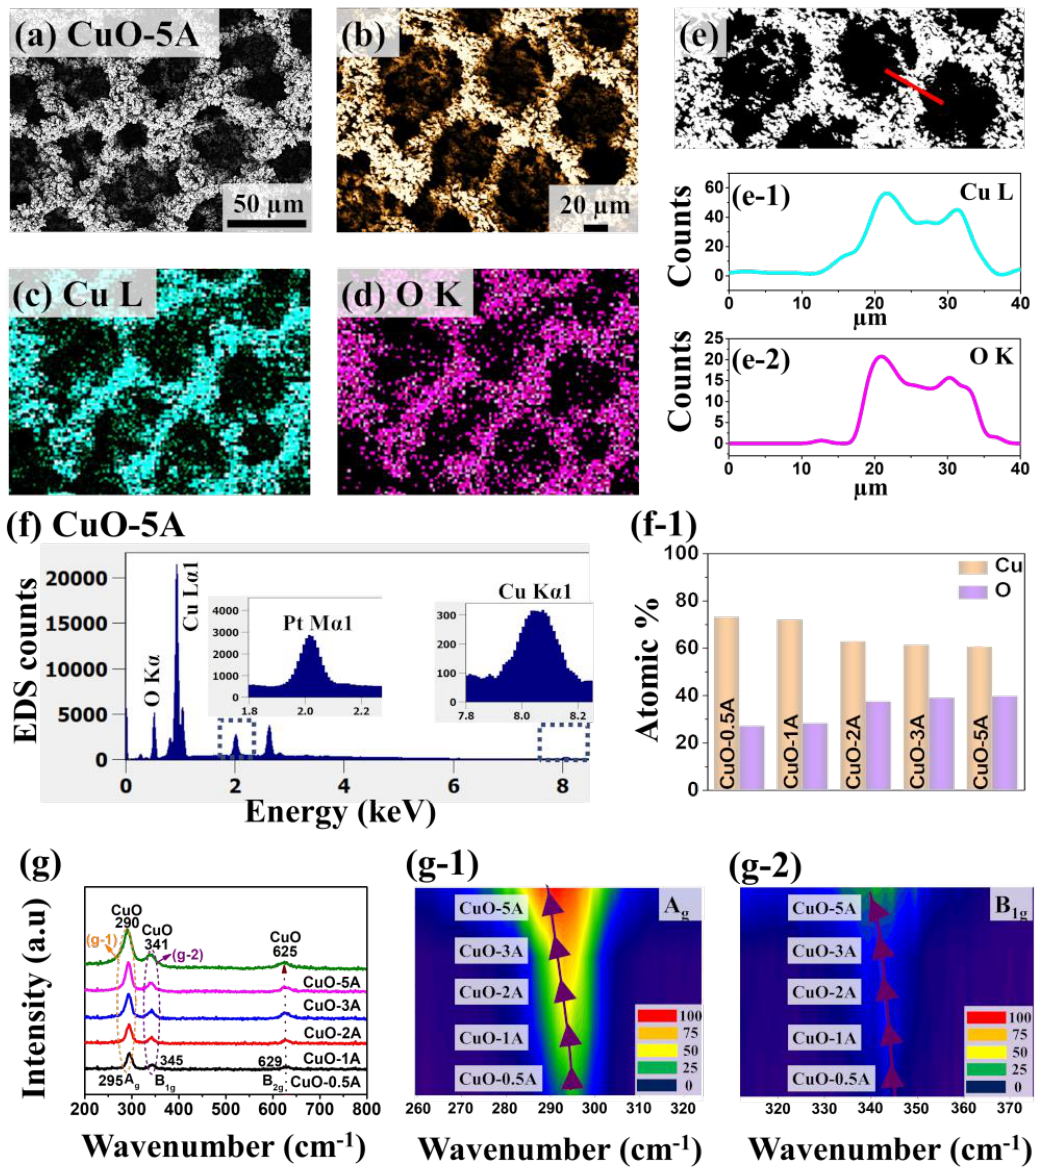
Figure 6. ( a ) SEM image of porous CuO / Pt hybrid detector fabricated at 5 A / cm 2 for 30 s and denoted as CuO-5A. ( b – d ) Enlarged SEM image and elemental maps of Cu and O for the CuO-5A. ( e – e-2 ) Elemental line-profiles of Cu L and O K. ( f , f-1 ) EDS spectra of CuO-5A and summary of atomic percentage of Cu and O as a function of deposition current. ( g ) Raman spectra for the porous CuO samples fabricated at di ff erent currents. ( g-1 , g-2 ) Contour maps of the Raman peaks of CuO corresponding to the A g and B1 g modes.